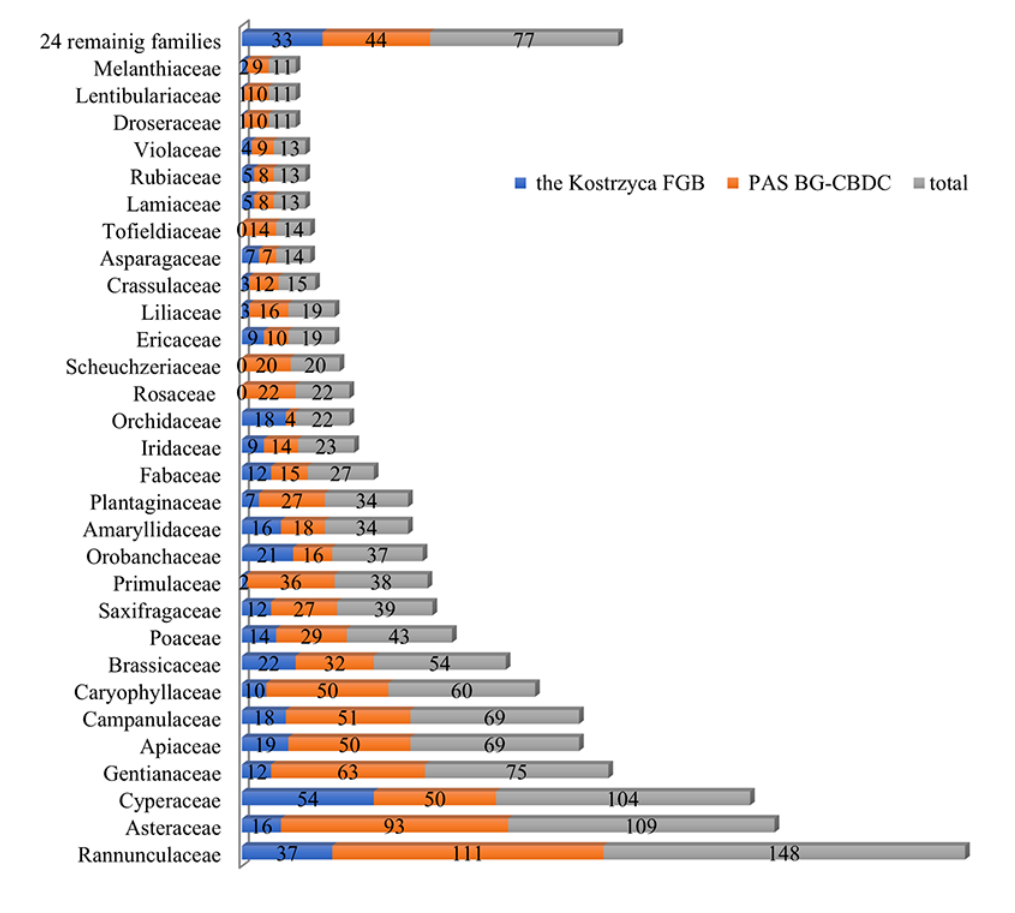
Figure 1 Number of accessions of individual herbaceous plant families whose seeds are cryopreserved in Polish cryobanks: Kostrzyca Forest Gene Bank (Kostrzyca FGB) and Polish Academy of Sciences Botanical Garden – Center for Biological Diversity Conservation in Powsin, Warsaw (PAS BG-CBDC). e class of “remaining families” refers to the groups of families with less than 10 accessions